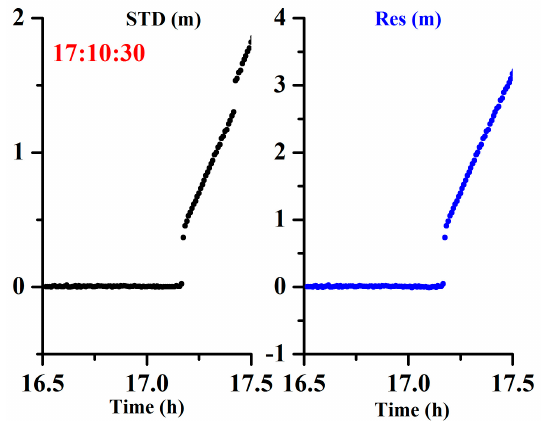
Figure 16. Time series of the STD of the observation residuals and array L for the global positioning system (GPS) medium earth orbit (MEO) satellites showing orbital maneuver (the left side represents the time discriminant factor, and the right side represents the satellite identification factor).